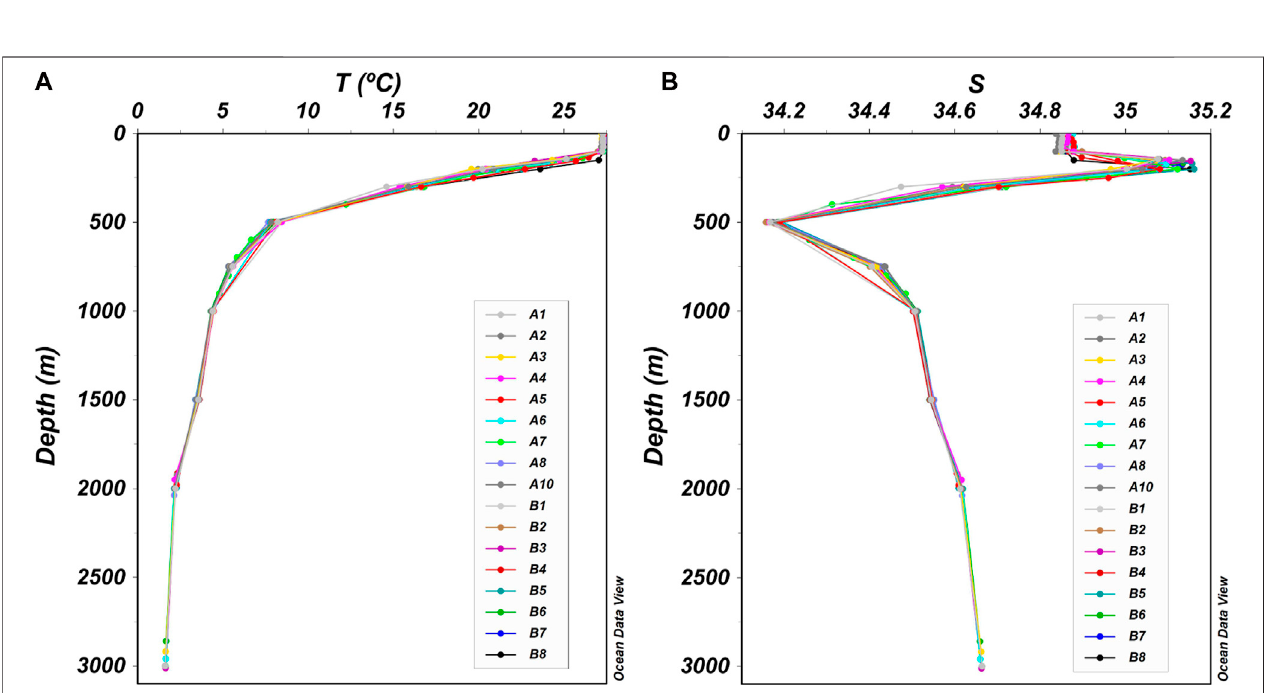
FIGURE2| Verticaldistribution oftemperature (T)and salinity (S)intheKocebuseamount area.Differentcolorsrepresenteddifferentstations. The TandSat each stationshowedasimilartrend,respectively. (A) TheTateachstation.Therewasathermoclineinthewatercolumnof100 – 500 m. (B) TheSateachstation.Therewasa high-salinity zone in the water column of 150 – 200